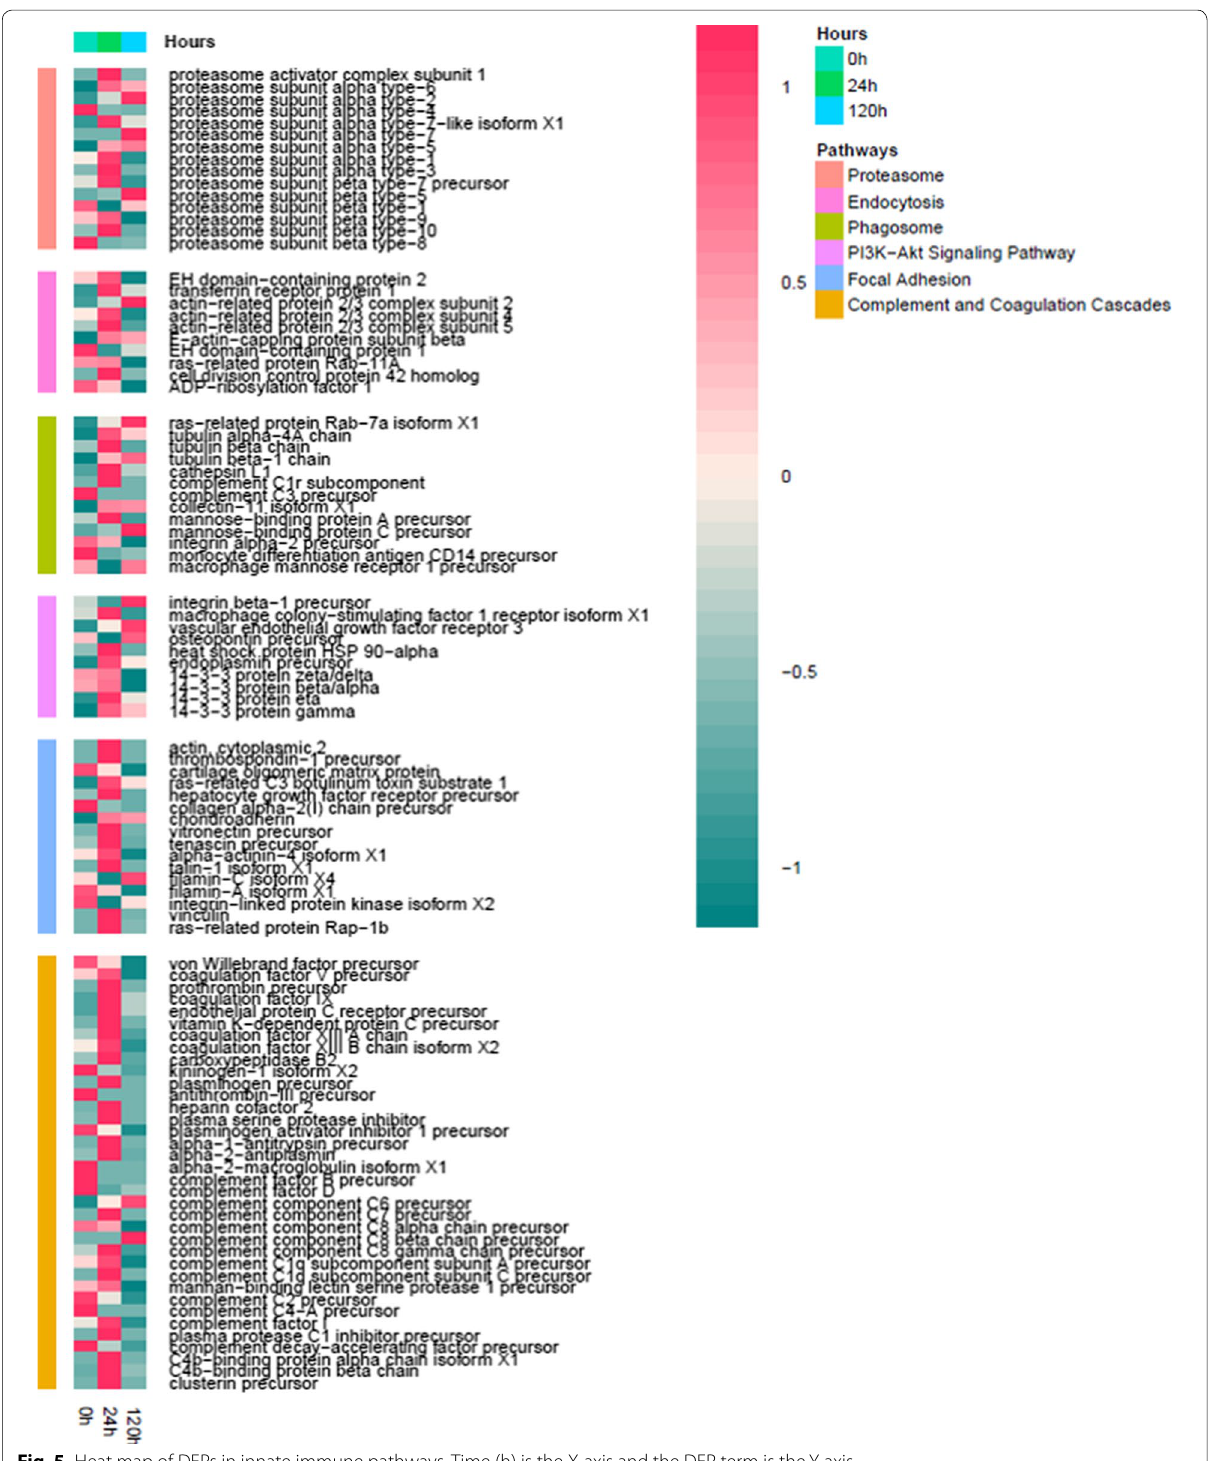
Fig. 5 Heat map of DEPs in innate immune pathways. Time (h) is the X-axis and the DEP term is the